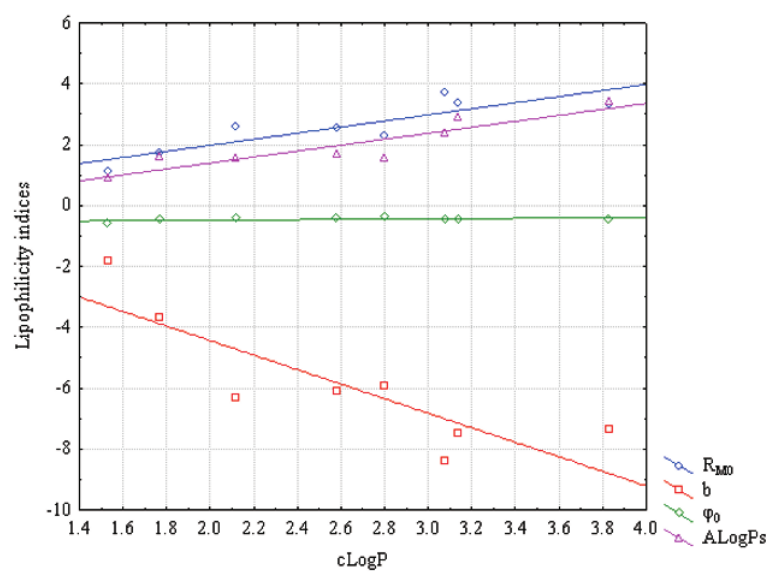
Figure 2. Scatterplot of experimental lipophilicity indices (R